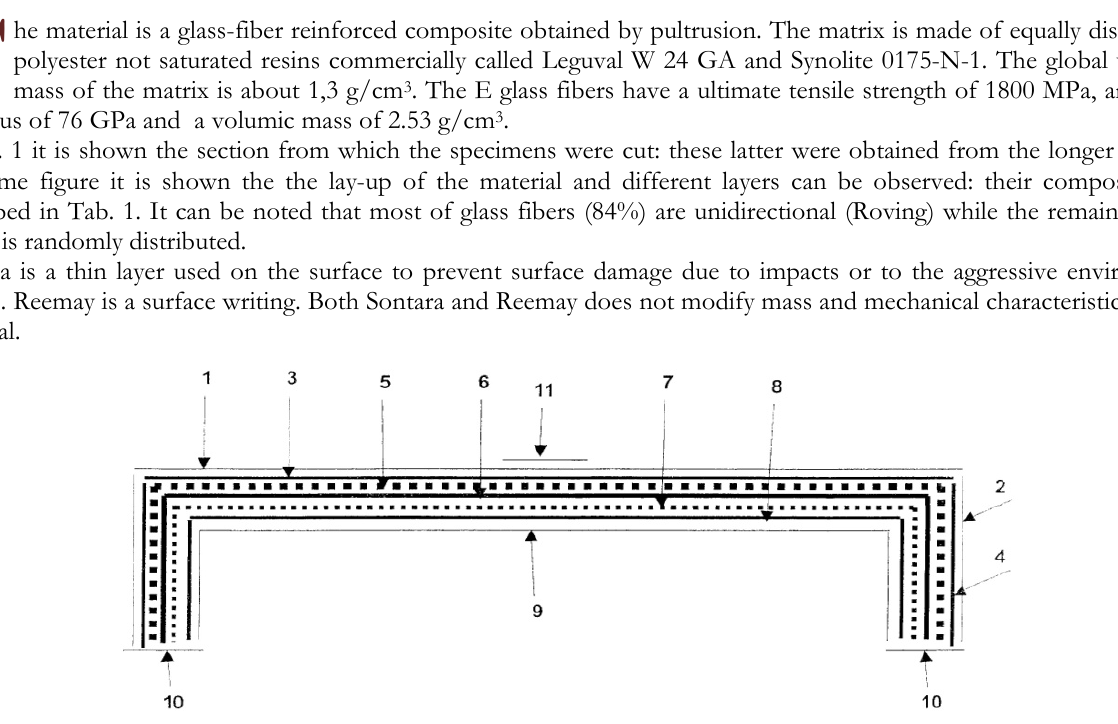
Figure 1: Section of the pultruded bar from which the specimens were